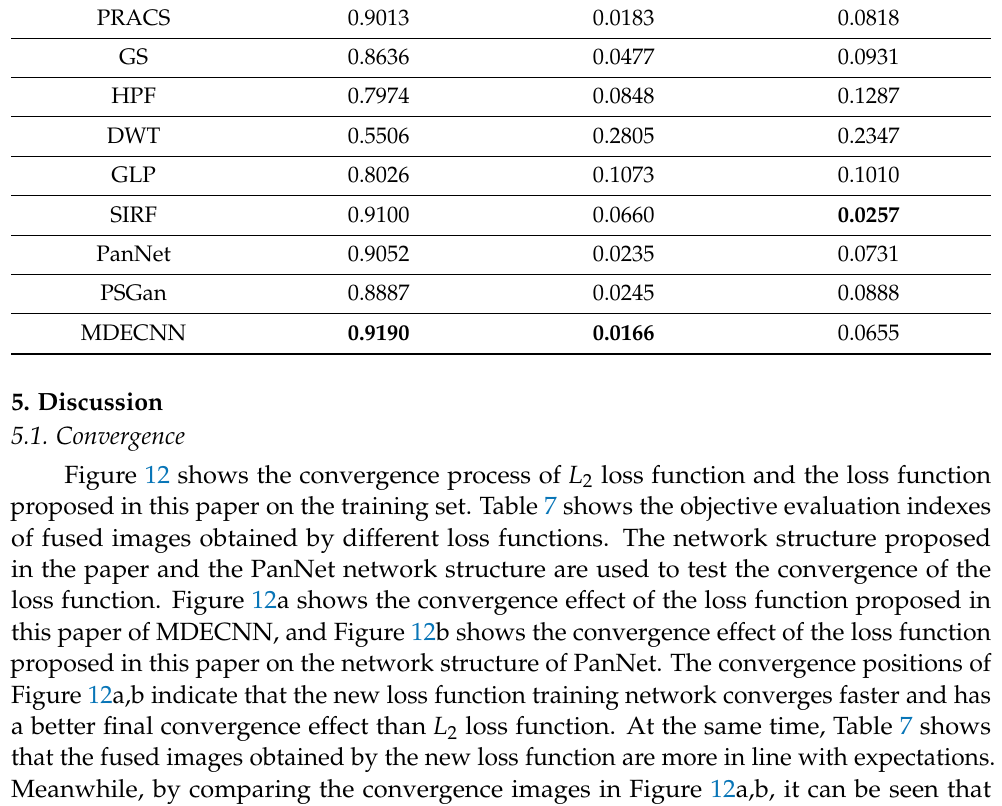
Table 6. Quantitative assessment of the GeoEye-1 real dataset shown in Figure 11. The best performance is shown in bold.